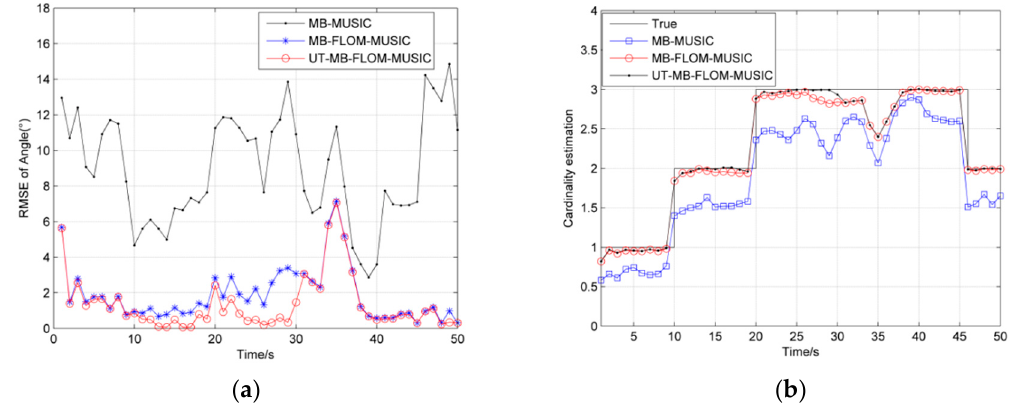
Figure 9. RMSE and cardinality estimation of angle under α = 1.3 and GSNR = 10 dB, MC = 100: ( a ) RMSE of angle; ( b ) cardinality estimation of angle.